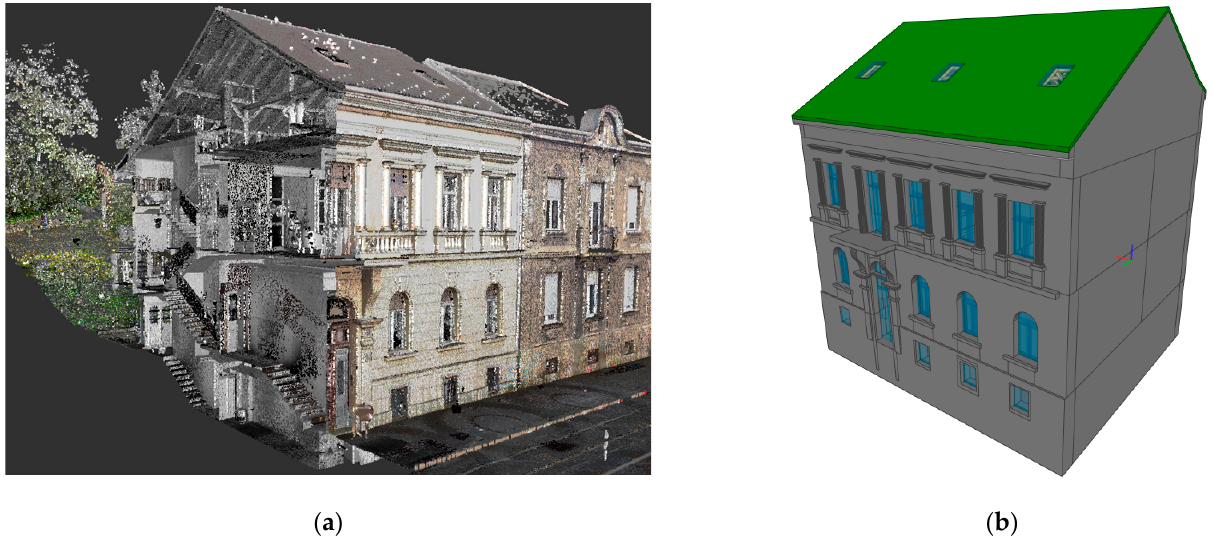
Figure 6. ( a ) 3D point cloud; ( b ) 3D vector digital model of the existing building. Reproduced with permission from GO2BIM d.o.o. Zagreb, 2022.